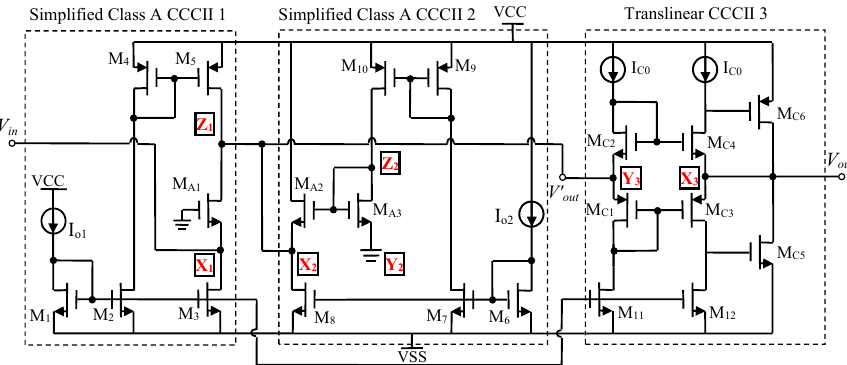
Figure 3. The schematic of the proposed CCCII-based LNA.